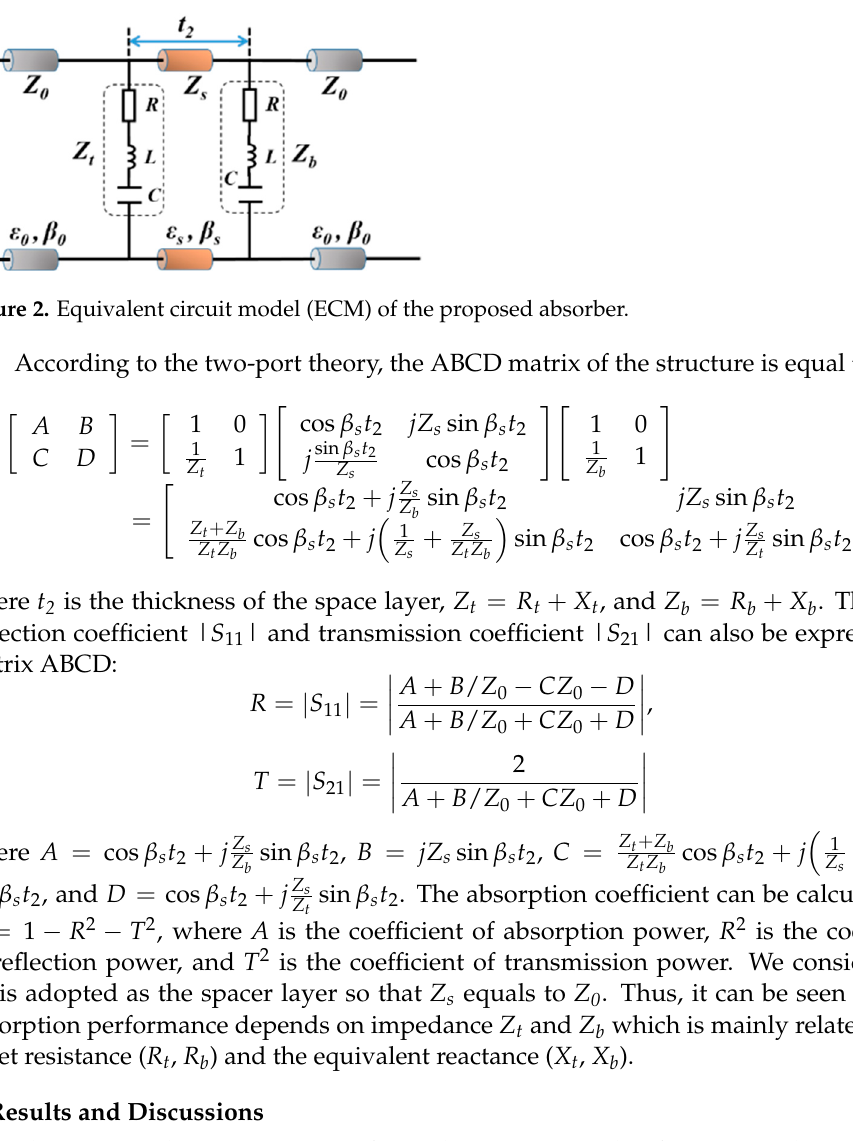
Figure 1. Schematic of the proposed absorber. ( a ) The top patterned silver nanowires (AgNWs) film. ( b ) The bottom patterned AgNWs film. ( c ) Cross-sectional view of the AgNWs film. ( d ) 3D view of the absorber.